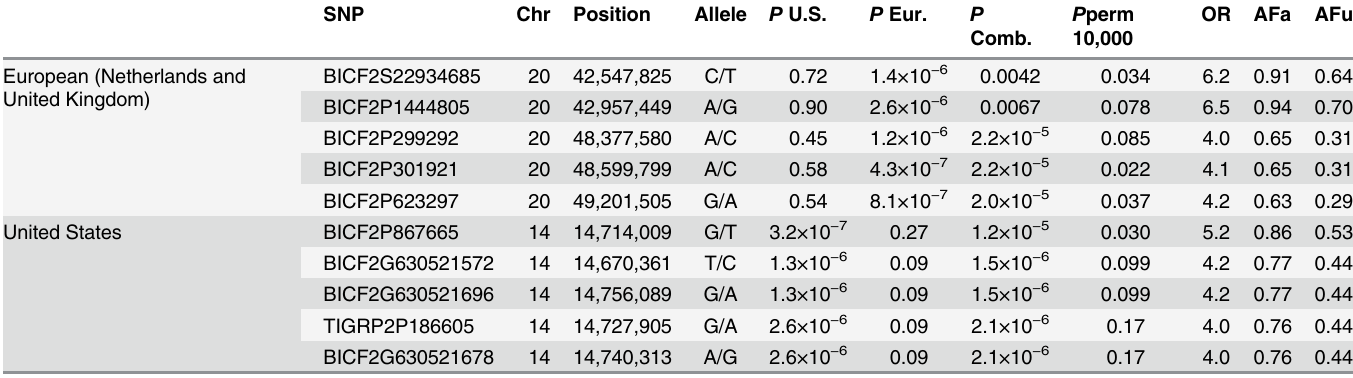
Table 1. Top-ranking GWAS SNPs from European and United States data. Table showing the 5 most associated GWAS SNPs from the European and American analysis. SNP Chr Position Allele P U.S. P Eur.